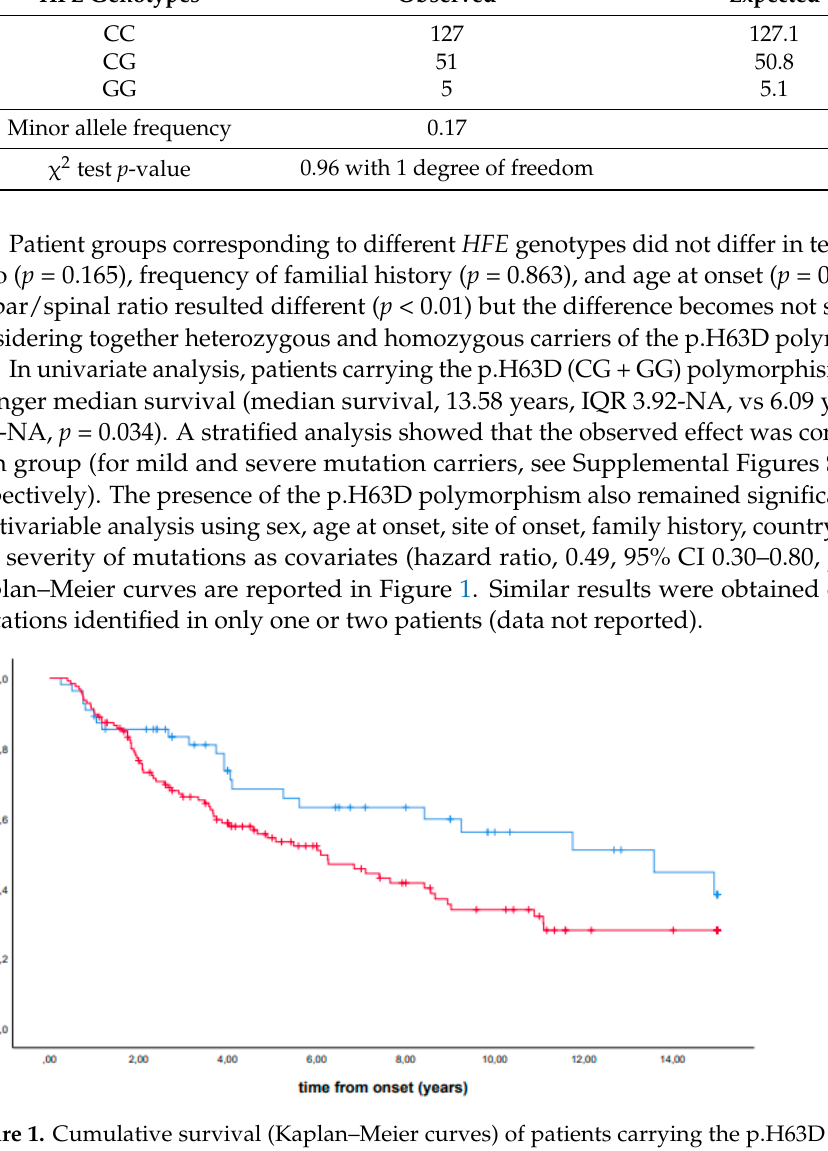
Figure 1. Cumulative survival (Kaplan–Meier curves) of patients carrying the p.H63D (CG + GG) polymorphism (blue line) versus non-carrier patients (red line).